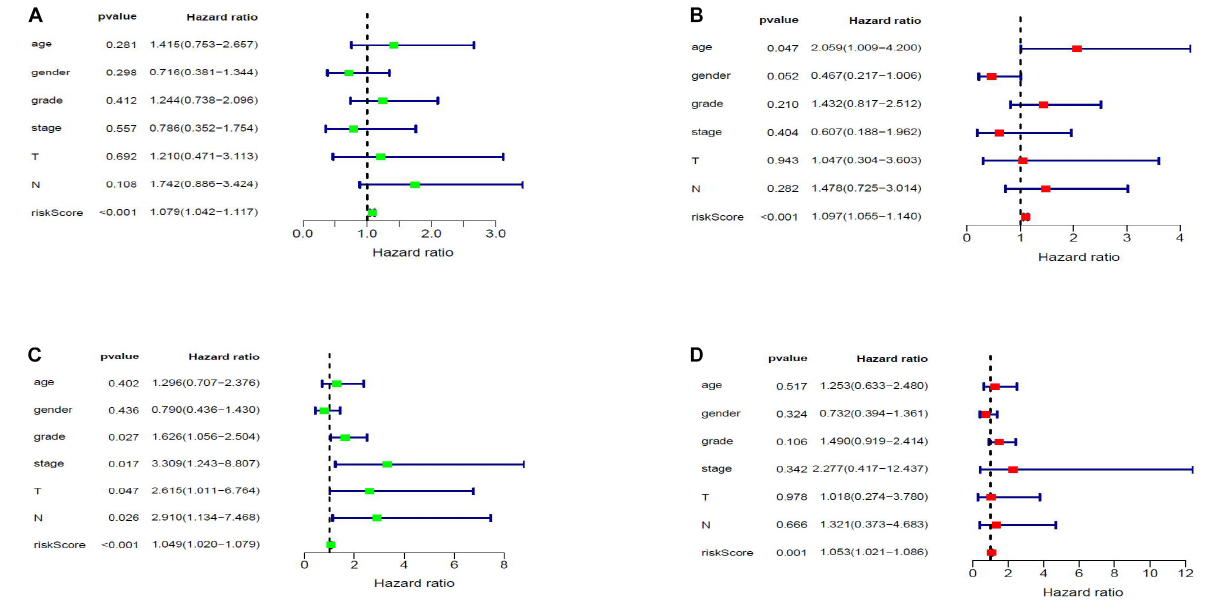
FIGURE 8 | Forest map of the relationship of risk score and clinical characteristics with prognosis in PAAD by univariate (A,C) and multivariate (B,D) Cox analysis. Panels (A,B) and (C,D) are forest maps of modeling and validation cohort,